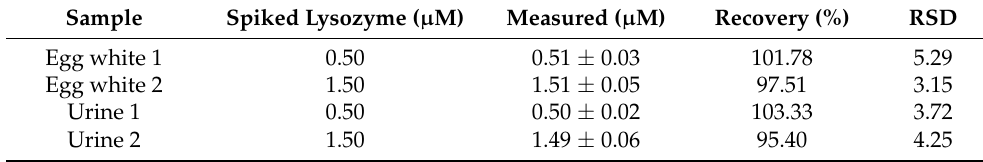
Table 1. Detection of lysozyme using MNP/QD@MIPs sensor in real